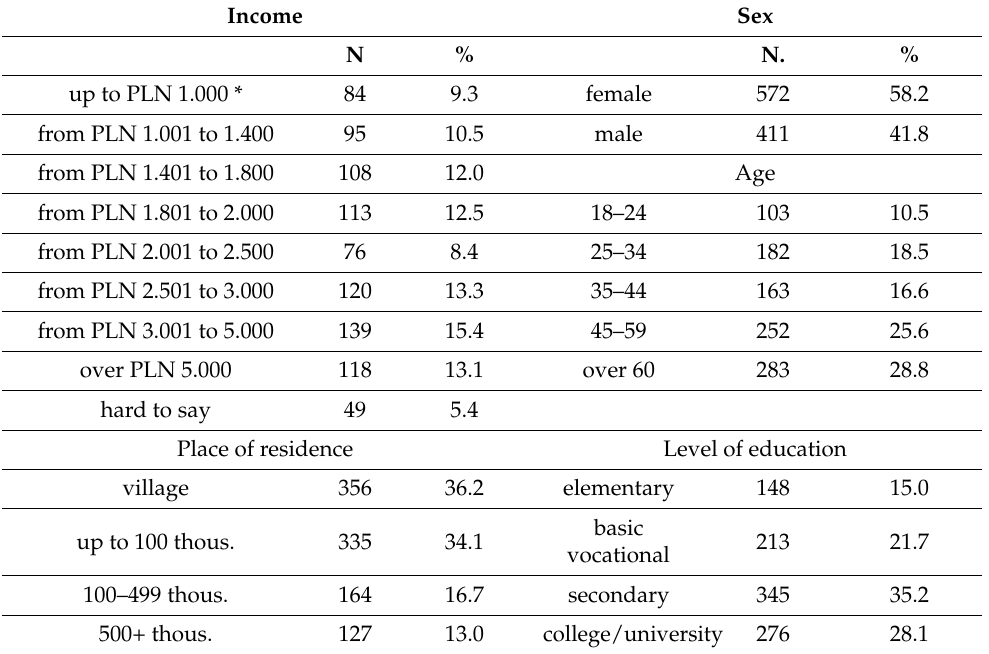
Table 3. Study sample structure.